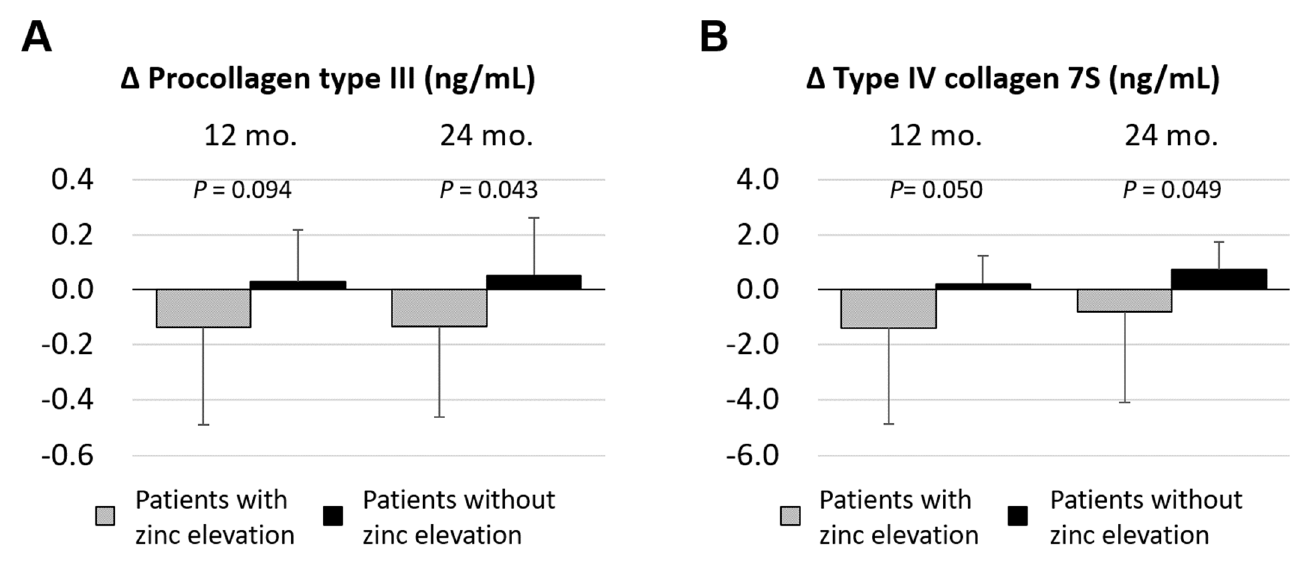
Figure 3. Longitudinal changes of serum fibrotic markers beyond zinc supplementation. ( A ) Changes of serum procollagen type III level after zinc administration of 12 and 24 months ( p = 0.094 and p = 0.043). ( B ) Changes of serum collagen type IV-7S after zinc administration of 12 and 24 months ( p = 0.050 and p = 0.049).